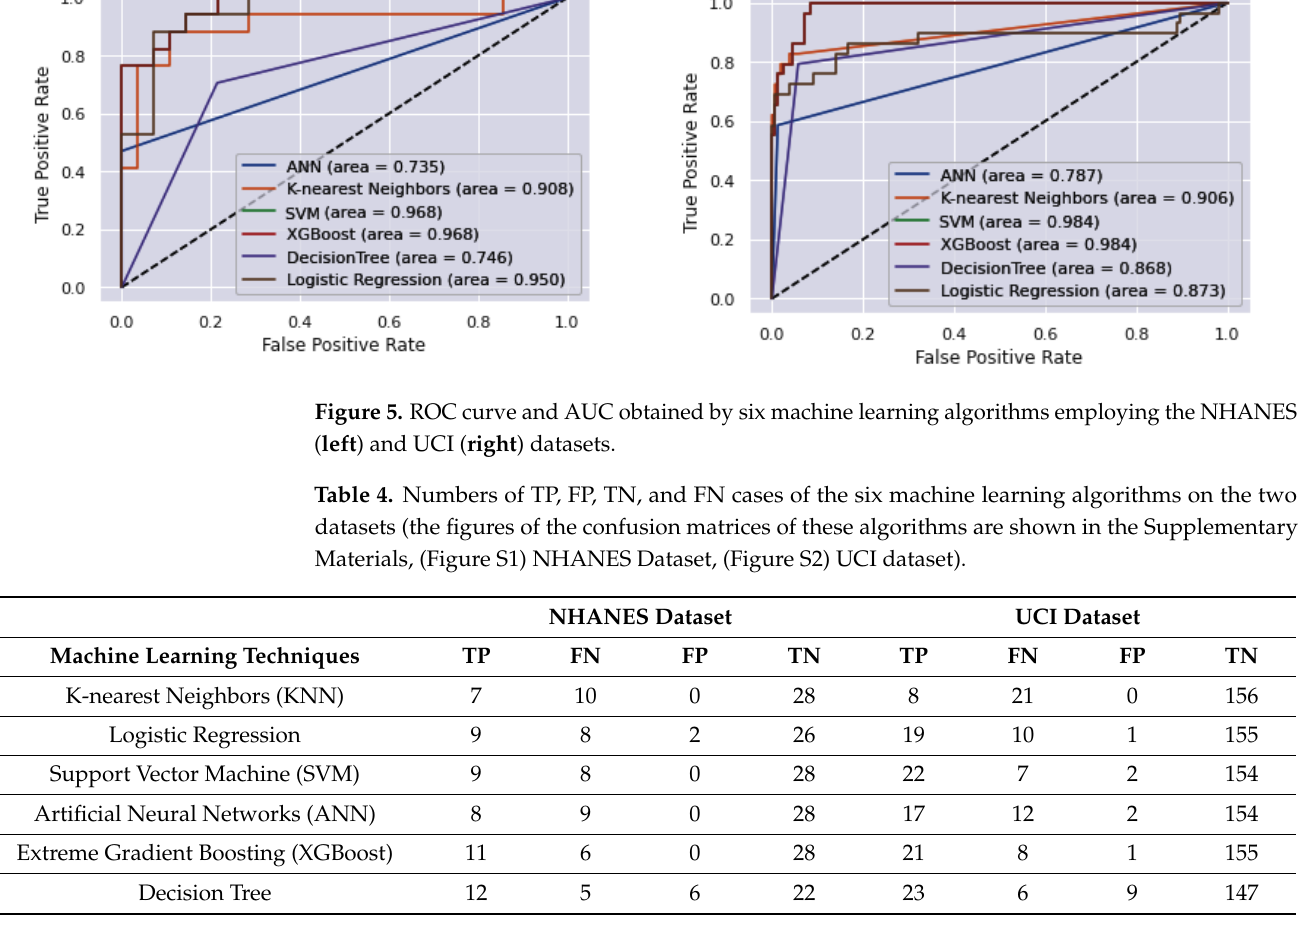
Table 5. Mean absolute error (MAE) in training and testing phases of the six machine learning algorithms on the two